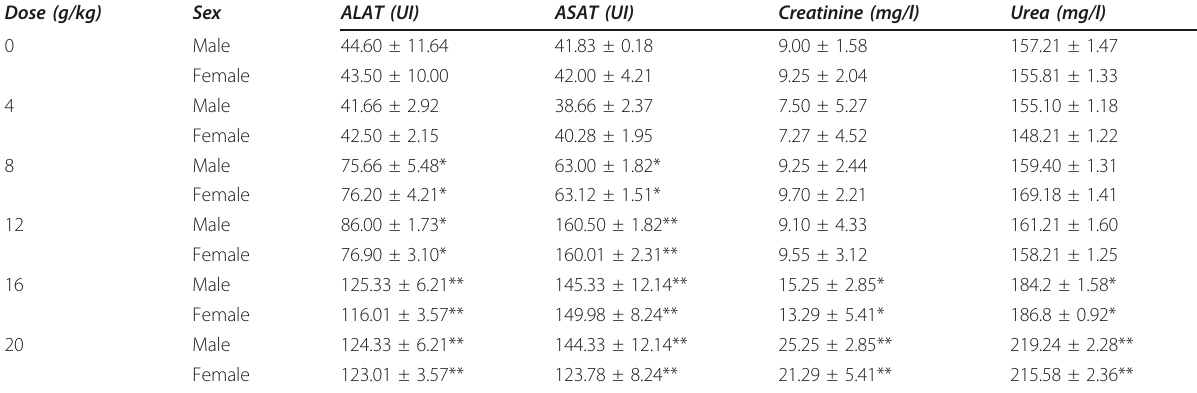
Table 6 Effect of the methanolic extract of Phyllanthus muellerianus on different sera biochemical parameters of male and female rats Dose